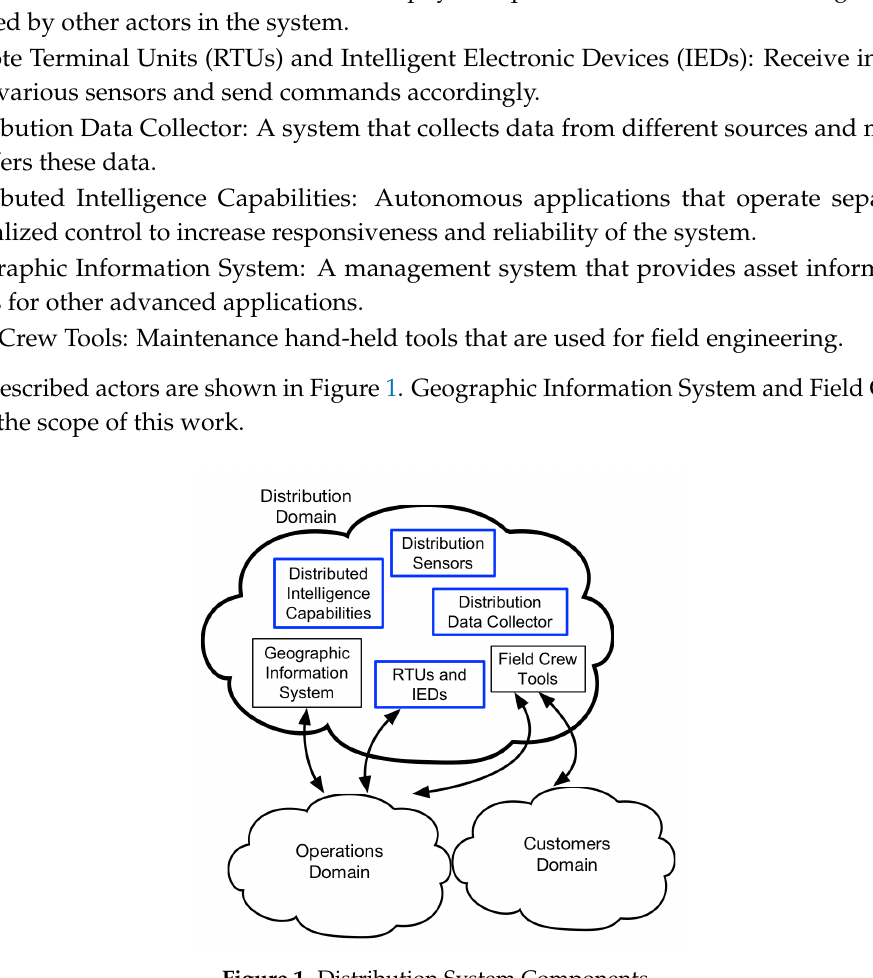
Figure 1. Distribution System